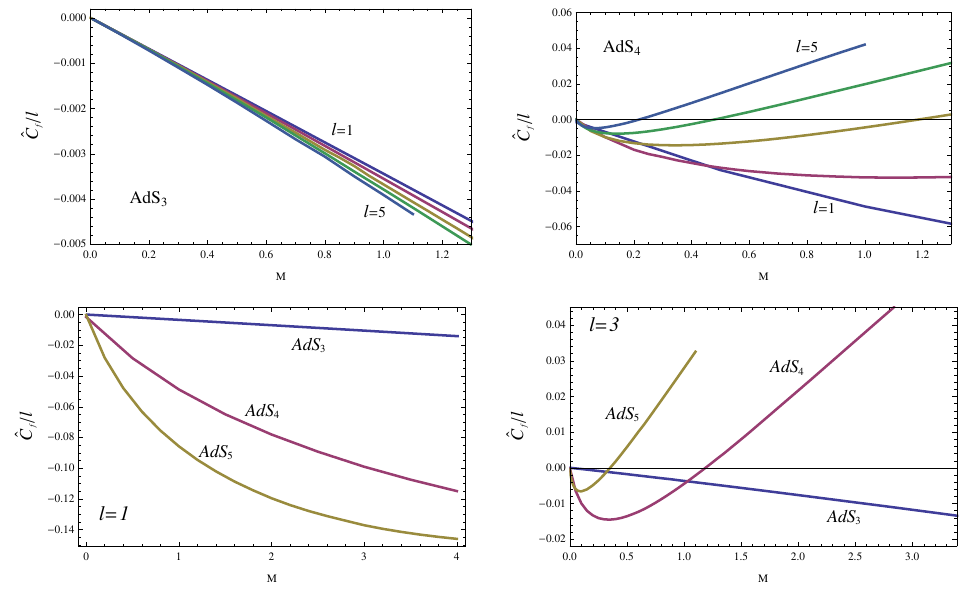
Figure 13 . The dependence of subregion complexity density ^ C f =l on the mass parameter M . The upper left panel is for AdS 3 and l = 1 ; 2 ; 3 ; 4 ; 5. The upper right panel is for AdS 4 and l = 1 ; 2 ; 3 ; 4 ;